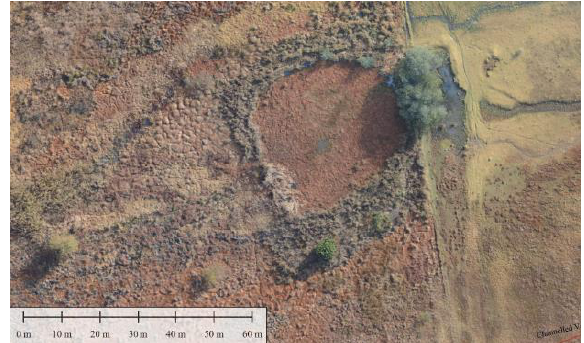
Figure 3. Estimation of disturbance classes from UAV orthophoto